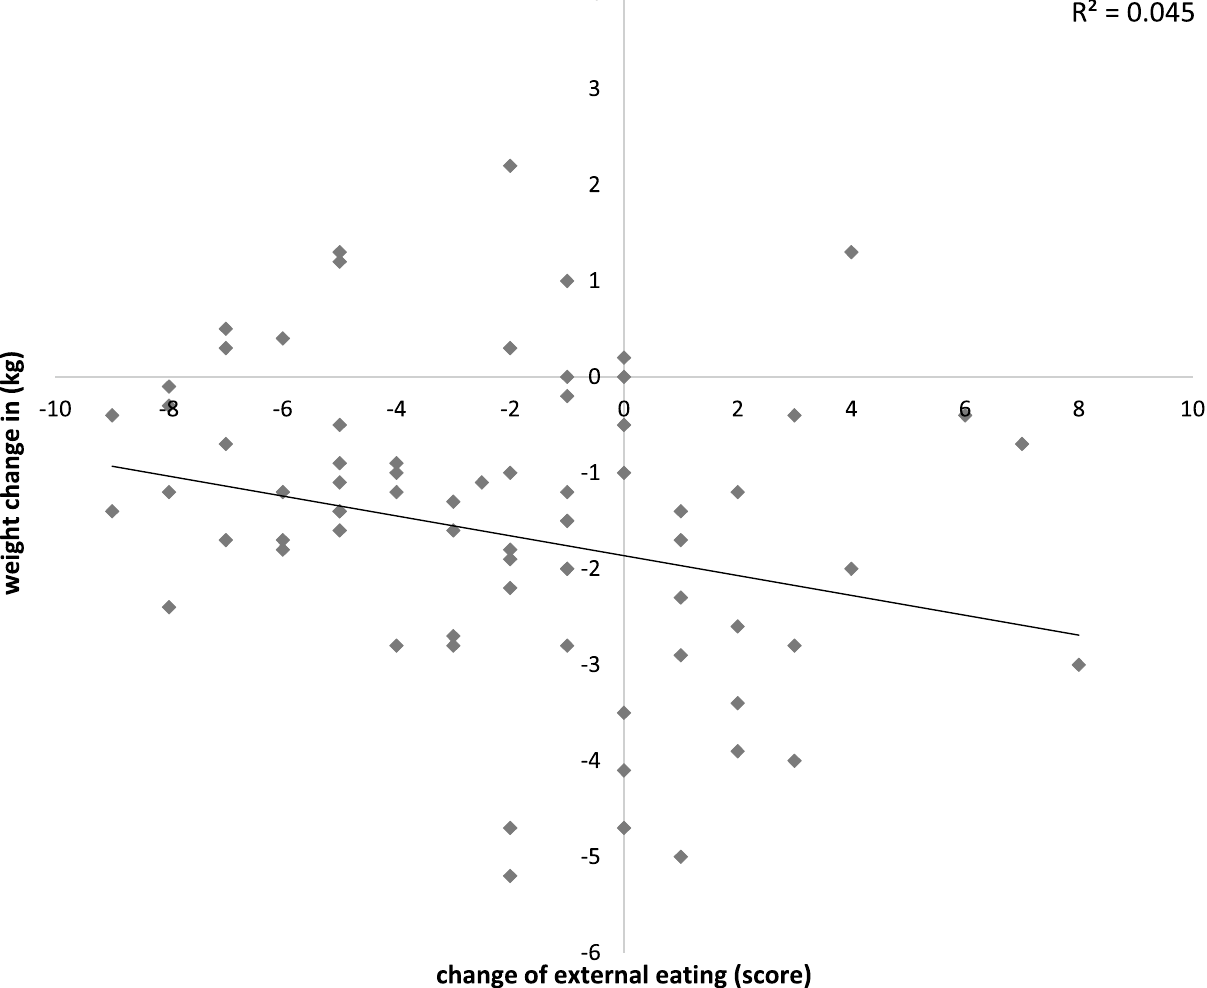
Figure 3. Correlation of the change of external eating and weight change in participants of the intervention group (n = 78) after 8 weeks; Spearman correlation coefficient (CC) = 0.285; p =